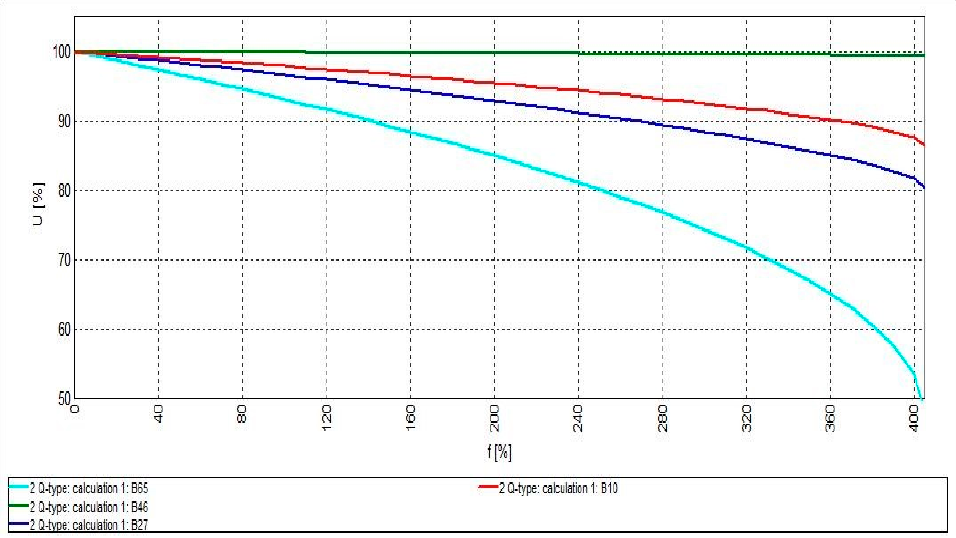
Figure 8. PV curves of the IEEE 69 ‐ node RDS system with 2 P ‐ type DG installations.